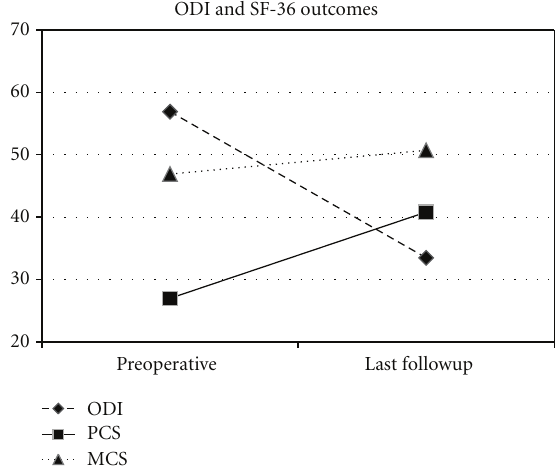
Figure 2: Change in minimum, maximum, and average low back pain (LBP) from preoperative to last followup (mean 11.5 months).